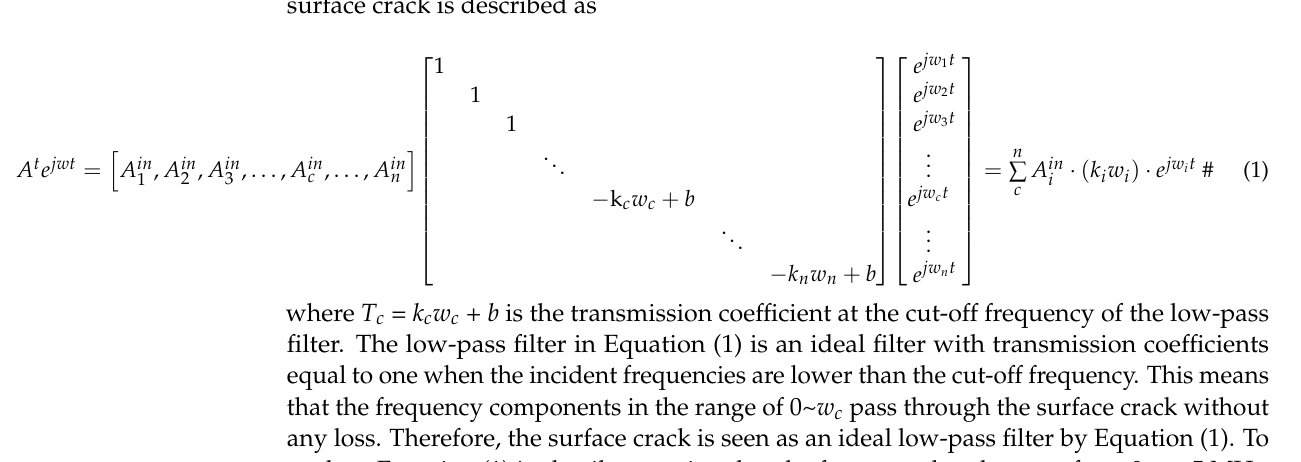
approximately T i ( w i ) = k × w i + b , where k denotes the transmission ability decrease with the frequencies and b is relevant to the crack depth. The transmitted Rayleigh wave at the surface crack is described as